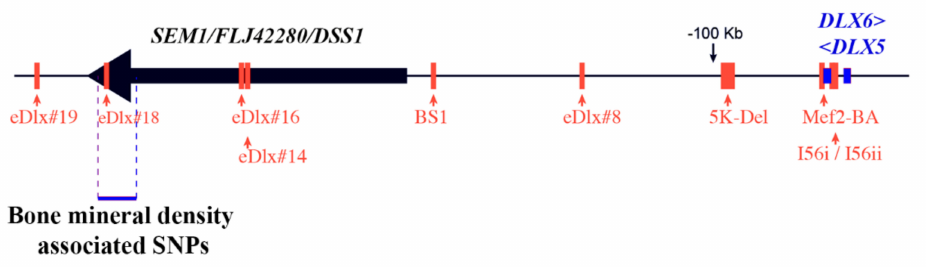
Figure 2. − A haplotype controlling bone mineral density spans over a DLX5/6 expression enhancer. The functional characterization of DLX5/6 regulatory region identified several enhancers (indicated in orange in the figure) directing the expression DLX5/6 [59]; furthermore a haplotype controlling bone mineral density and osteoporosis susceptibility has been reported in this locus [122]. At least four GWAS studies have found a strong association between bone mineral density (BMD) and SNPs in the 7q21.3 region, which includes the enhancer “eDlx#18” [117–121], prompting our suggestion that DLX5/6 should be included in the list of genes controlling BMD. This region is located in proximity to the gene SEM1/FLJ4220/DSS1 , of unknown function, but associated to